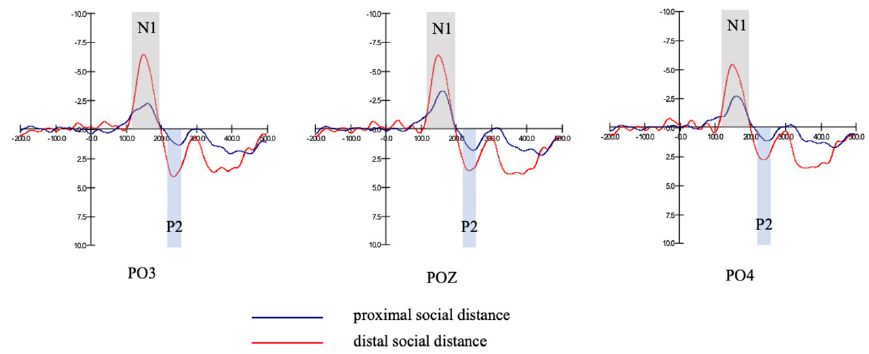
Table 9. Tests of Between ‐ Subjects Effects of N1 amplitude (prevention focus).